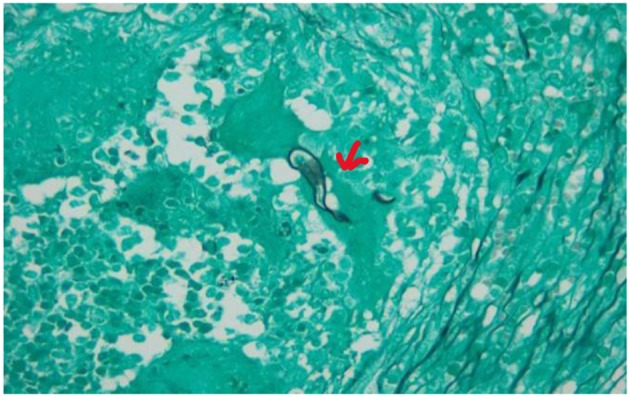
Grocott stain of the excised bowel. Basidiobolus hyphae (see red arrow). Typically thin-walled, septated hyphae, haphazardly branching, surrounded by eosinophilic material.